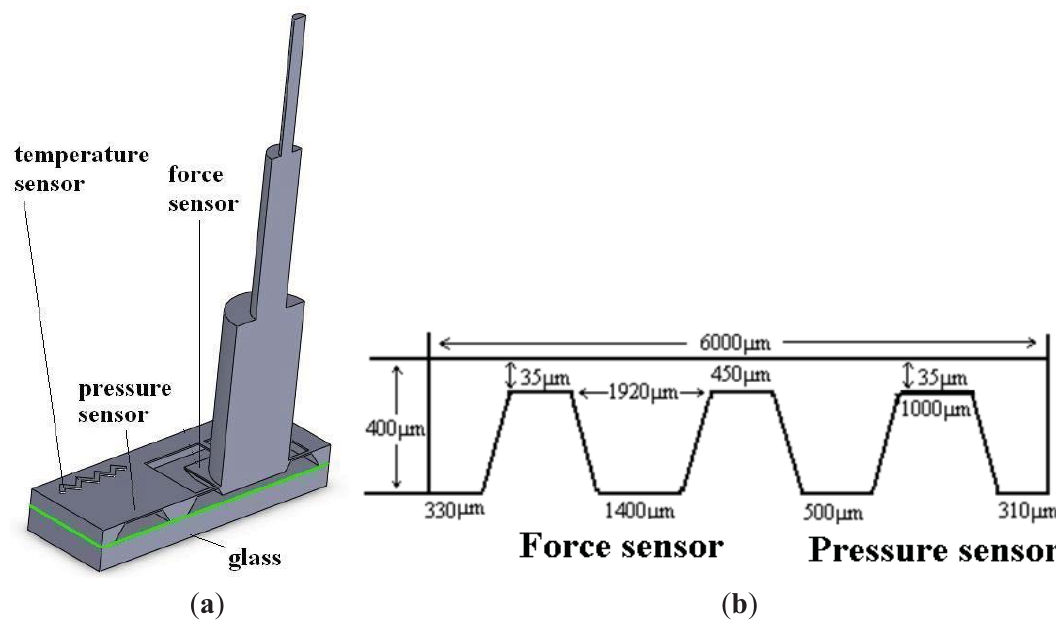
Figure 2. The strain distribution of the micro-force sensor. ( a ) Force (3 mN) applied in X or Y orientation; ( b ) Force (10 mN) applied in Z